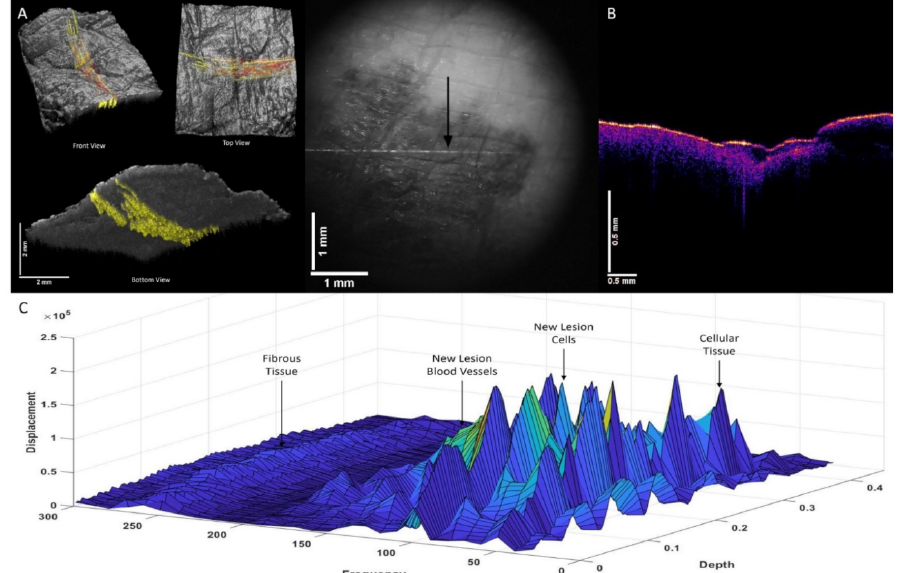
Figure 7. Three-dimensional color-coded OCT images ( A ) of a melanoma illustrating the location of new dermal cells and blood vessels (red) and fibrotic tissue (yellow) and ( B ) an OCT cross-section of a melanoma where the data were collected just below surface of lesion in the center. ( C ) shows 3D plots of weighted displacement versus frequency and depth showing the location of skin cells (50 Hz), new lesion cells (80 Hz), papillary collagen (100 Hz), new lesion blood vessels (130 Hz), and fibrotic tissue (260 Hz). Note that the fibrotic tissue peak (260 Hz) is small in the melanoma due to the absorption of infrared light by the melanin in the